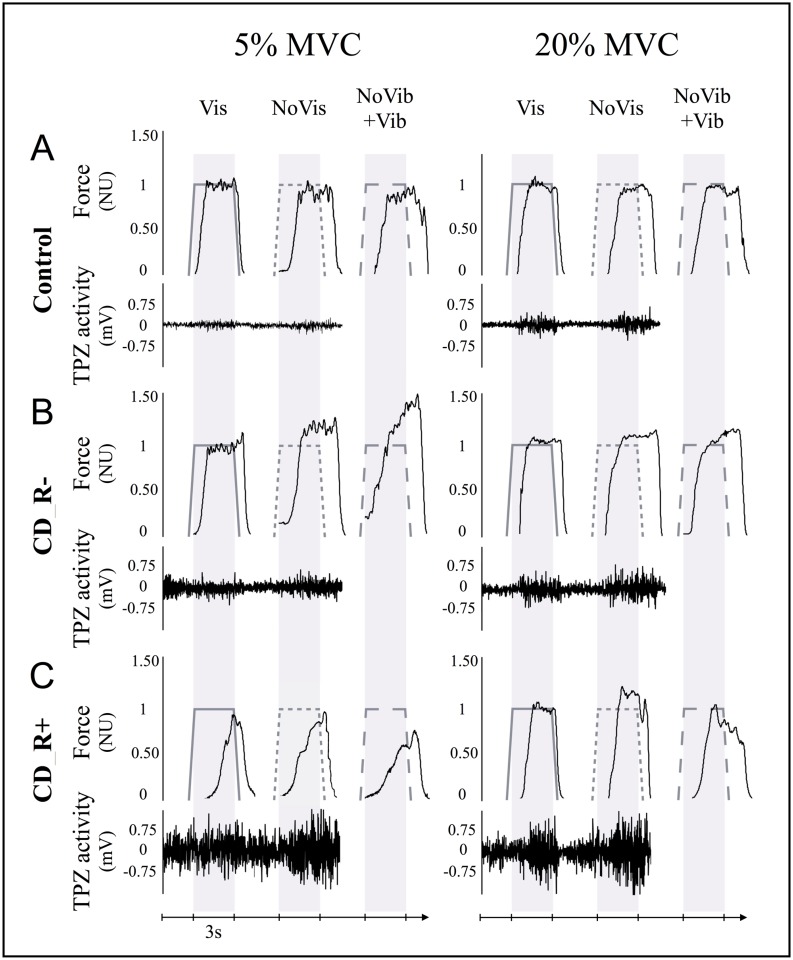
Comparison of raw data for a control subject, a CD_R- and a CD_R+ patient.(A) Control subject: raw data recorded during the force matching task at 5% MVC and 20% MVC: Neck extension force was first down-sampled (100Hz) and normalized for each subject to the target force level (NU: normalized units). Lower trace: EMG activity of right trapezius (TPZ). Example trials show force and EMG traces during condition_Vis, condition_NoVis, and condition_ NoVis+Vib. Note: EMG was not recorded during vibration. (B) CD_R- patient: corresponding examples. (C) CD_R+ patient: corresponding examples.